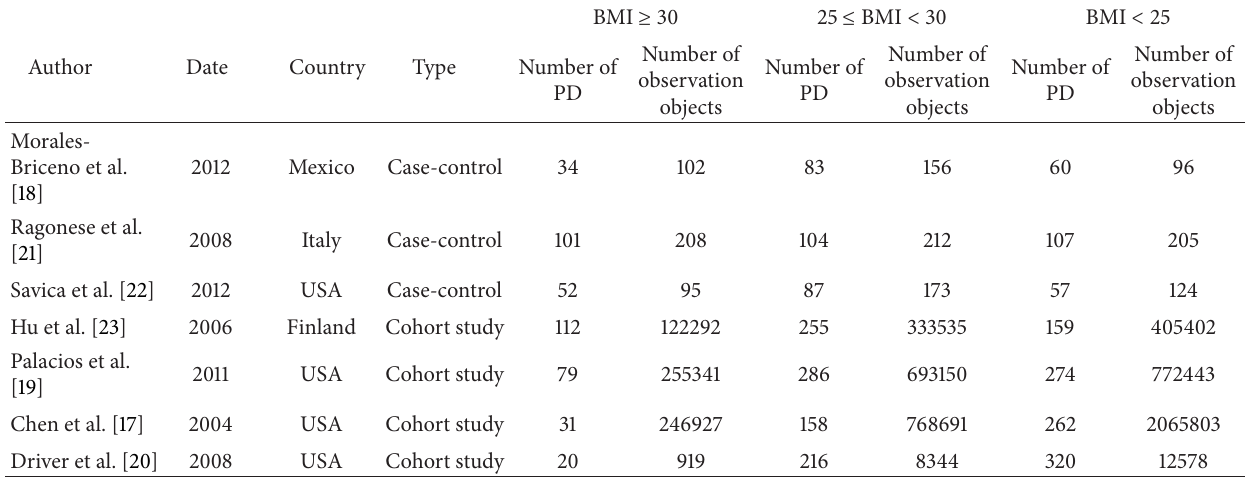
Table 1: Characteristics of the studies included in the